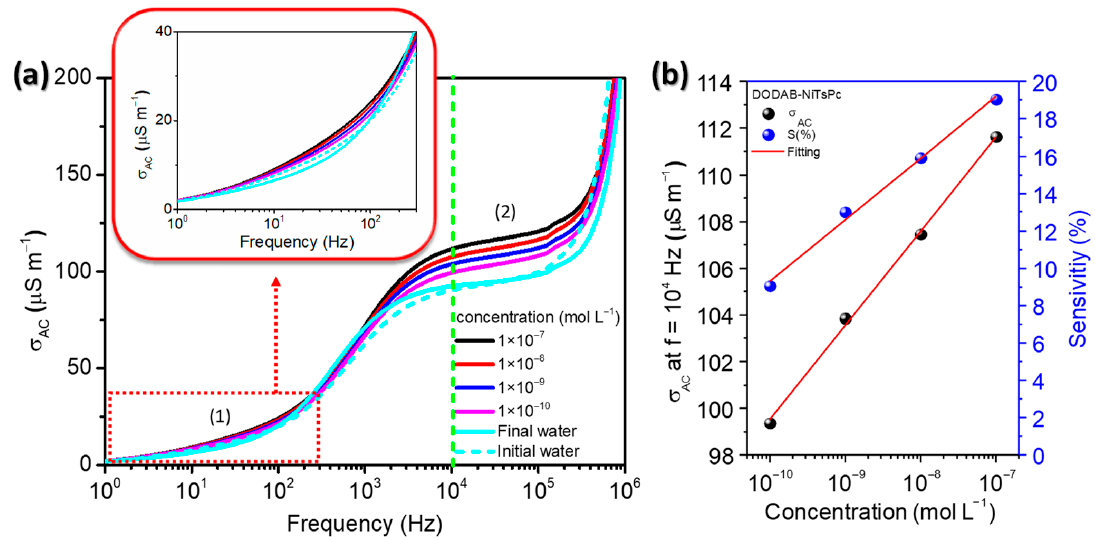
Figure 6. ( a ) ac conductivity versus frequency of the (DODAB/NiTsPc) 5 when immersed in ultrapure water and at different concentrations of MBC. Inset: zoom at the low frequency region. ( b ) Analytical curve of ac conductivity at 10 4 Hz and sensitivity versus MBC concentration. IDE 10.